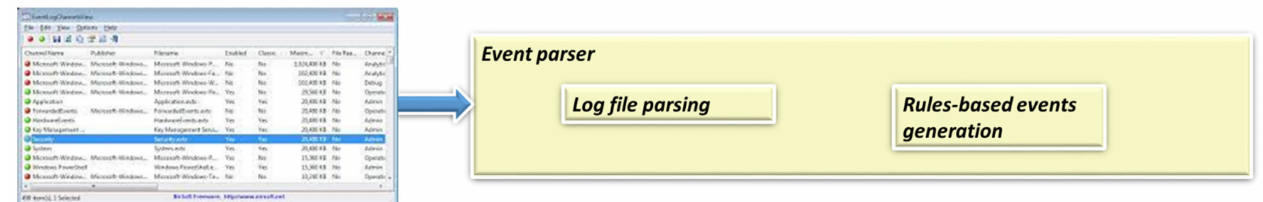
Figure 3. Zoom-in of events parser Modules 1 and 1 (cid:48)